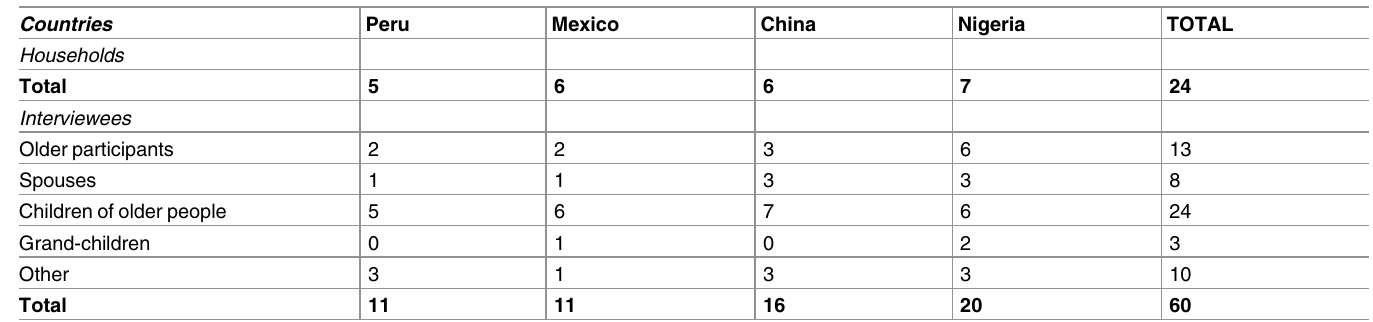
Table 1. Description of INDEP qualitative participants by country.